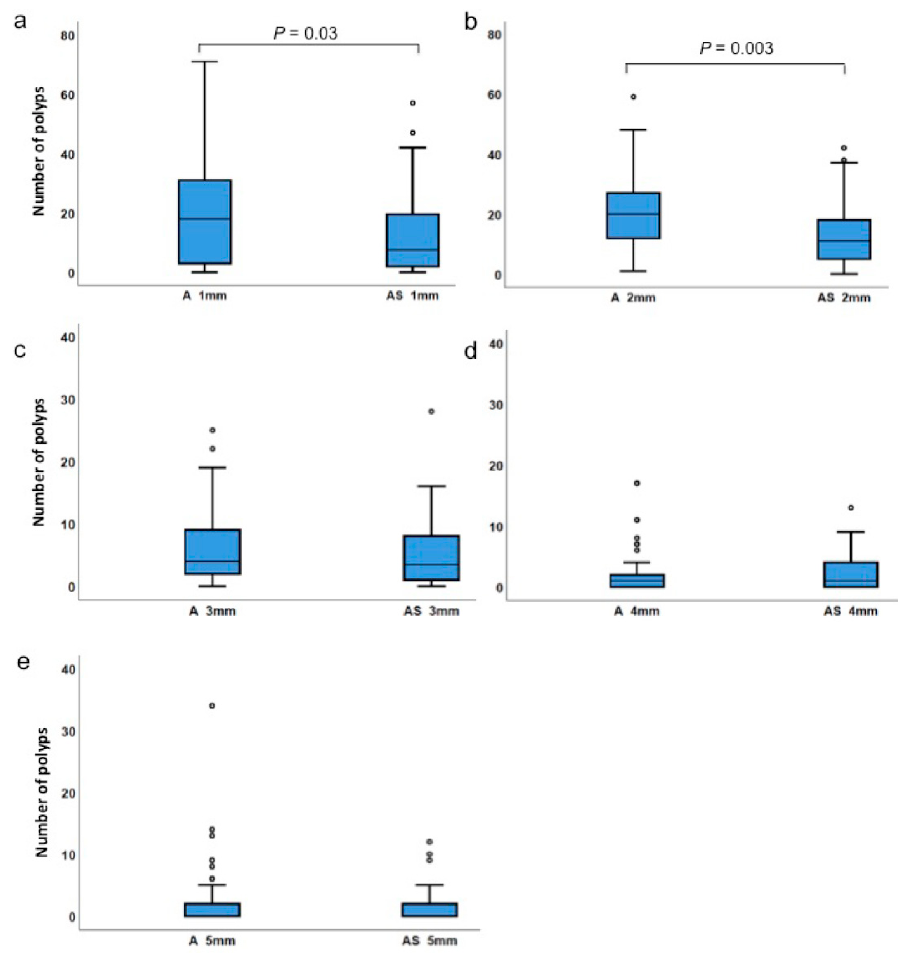
Figure 3. Polyp size comparison. ( a ) Comparison of polyps in Apc Min /+ (A) and ApcMin /+ ;Sf1 +/ − (AS) mice of sizes of 1 mm, ( b ) 2 mm, ( c ) 3 mm, ( d ) 4 mm and ( e ) 5 mm. Quartile values are represented as described in the legend of Figure 2. Actual values are listed in Table